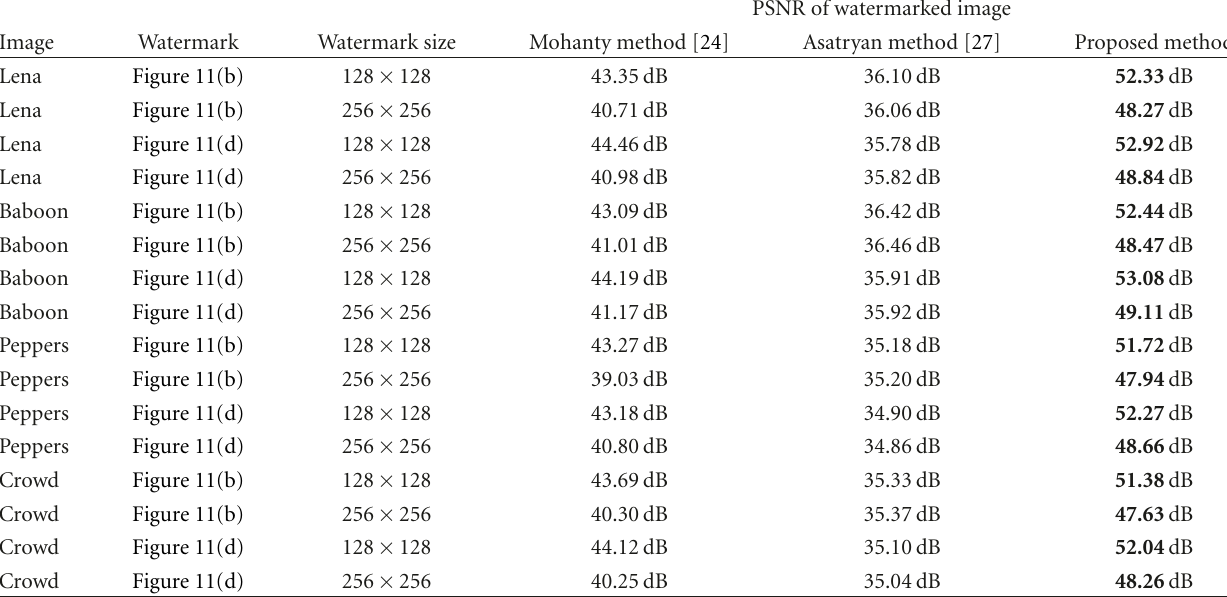
Table 6: PSNR value of watermarked image (512 × 512) by several